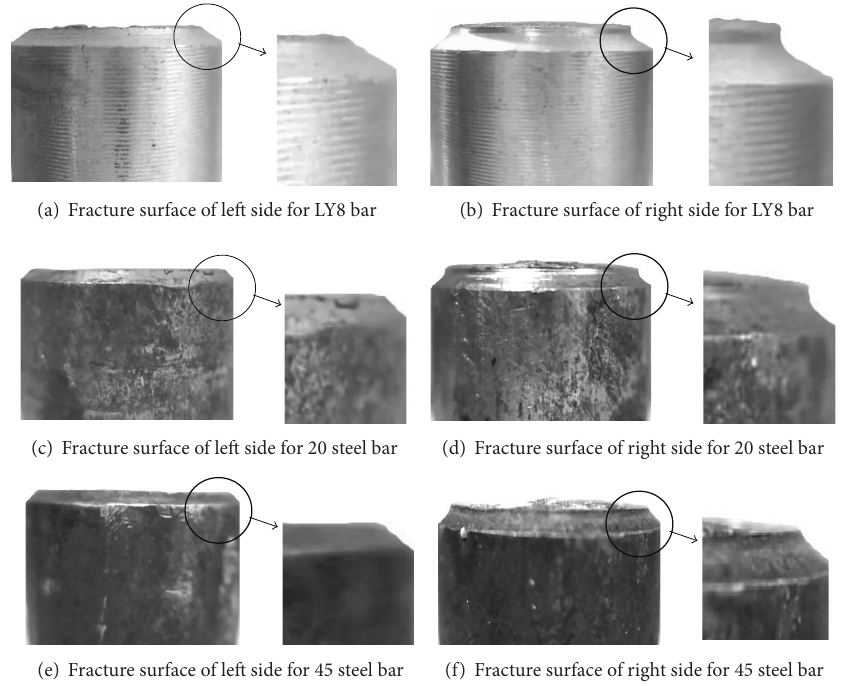
Figure 5: Fracture geometrical forms of left side and right side of V-shaped notch bottom surface.